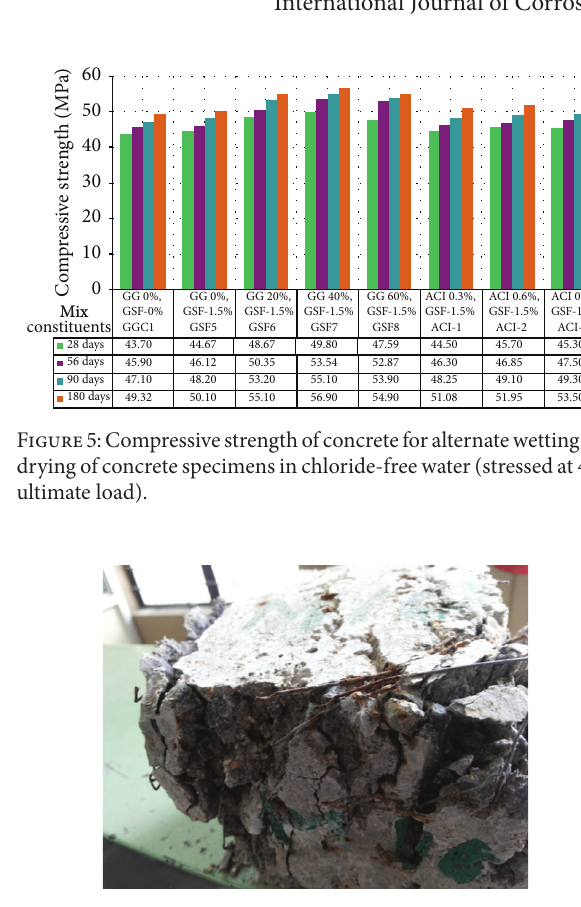
Figure 6: Failure pattern of corroded steel fibre concrete